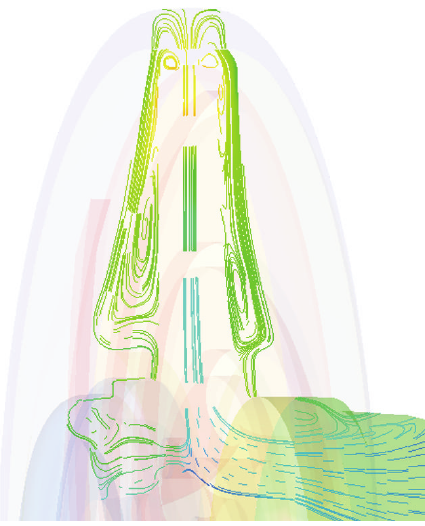
Figure 9: Streamline of flow inside